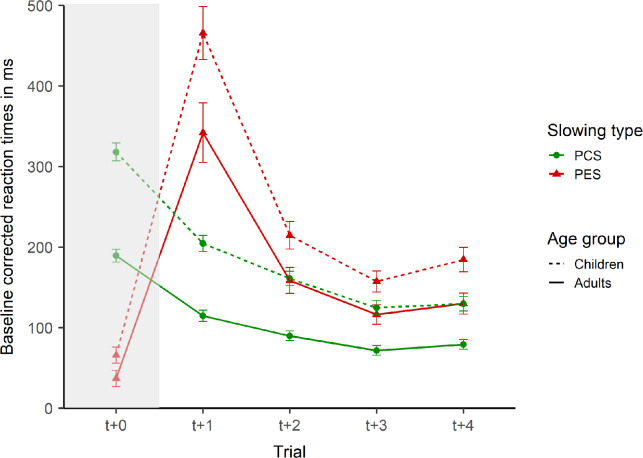
Post-Conflict slowing and post-error slowing.Baseline corrected reaction times of children (dotted line) and adults (solid line) on incongruent trials (t+0) and the following correct congruent trials (t+1, t+2, t+3, t+4). The slowing type depends on the correctness of trial t+0. Post-Conflict Slowing (PCS; green line, circles) follows a correct response and Post-Error Slowing (PES; red lines, triangles) follows an incorrect response. Error bars represent standard errors of the mean.